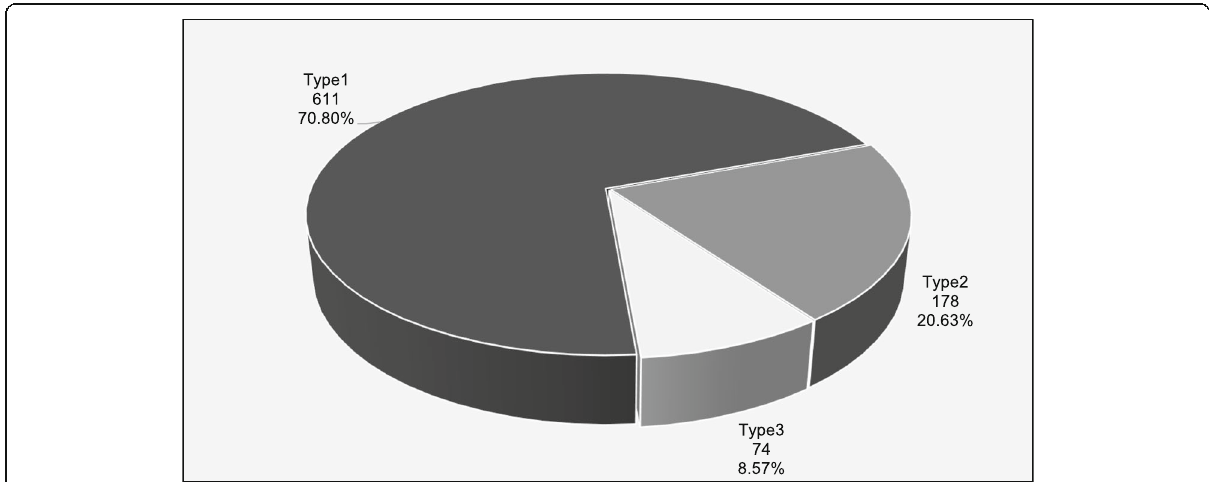
Fig. 5 Proportion of different types of cattle farming system in